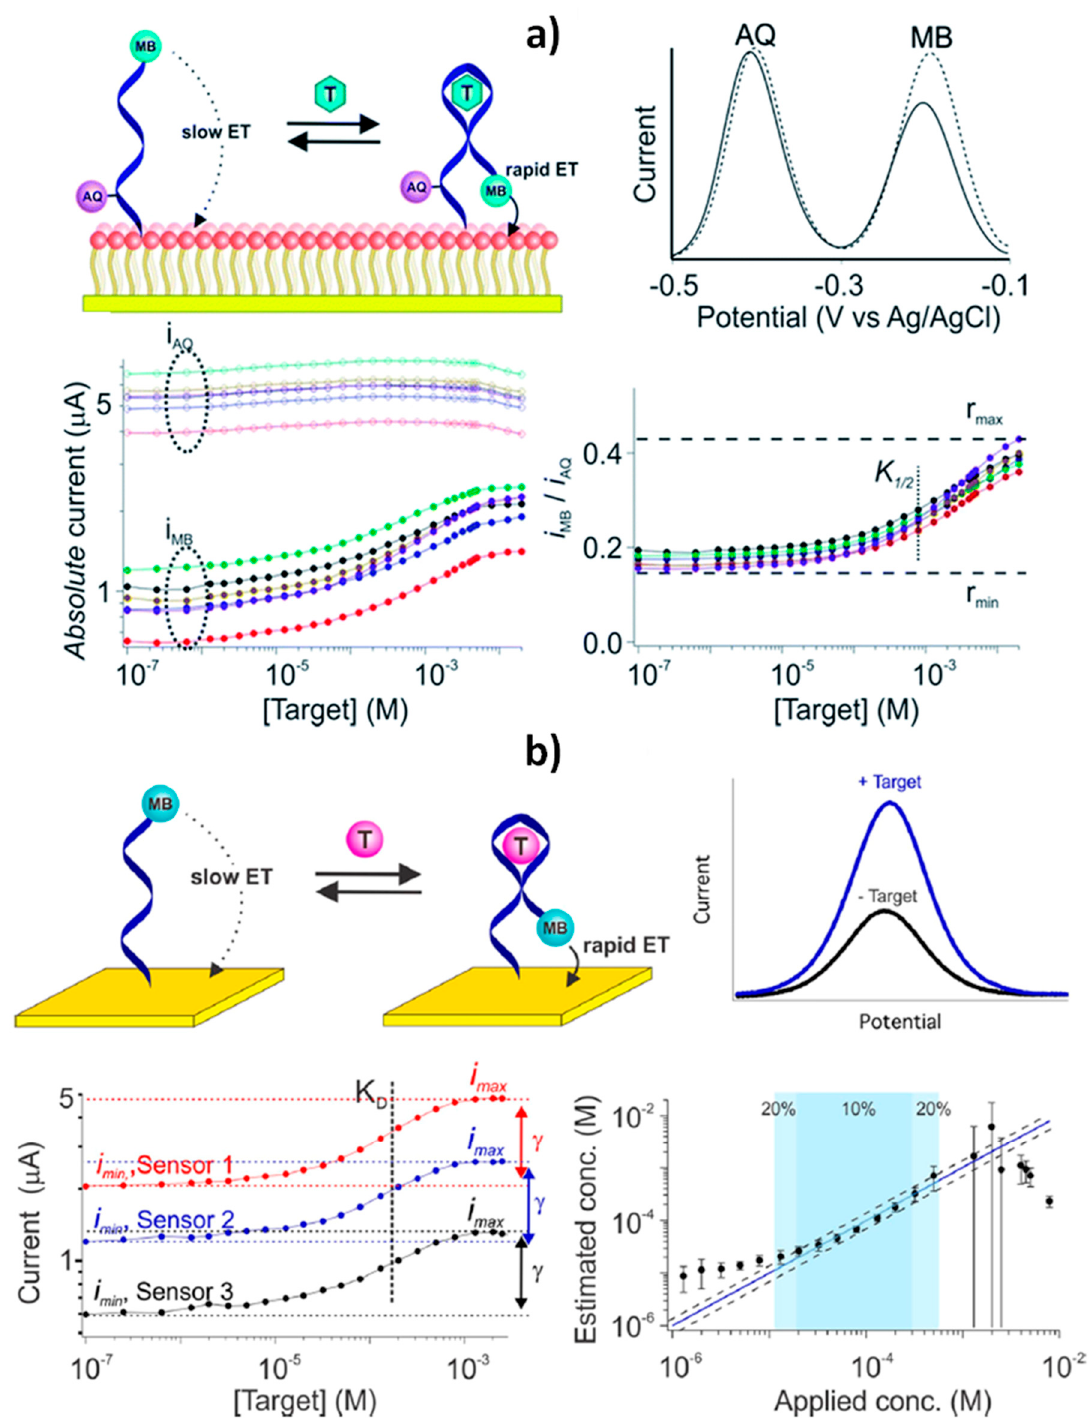
Figure 7. Schematic display of calibration-free E-AB biosensors based on “dual-reporter” ( a ) and “dual-frequency” ( b ) strategies. Reprinted and adapted from [2] (a) and [7] (b) with permission.